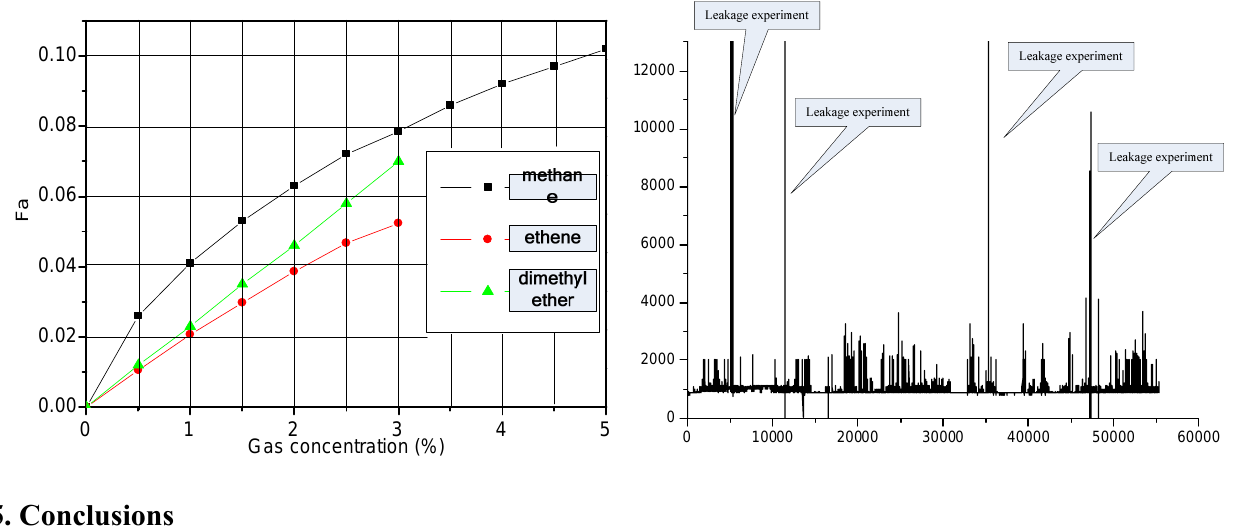
Figure 11. ( a ) Three types of gas sensor response relationships (ethylene, methane, dimethyl ether); ( b ) Experimental results for sea transportation of dimethyl